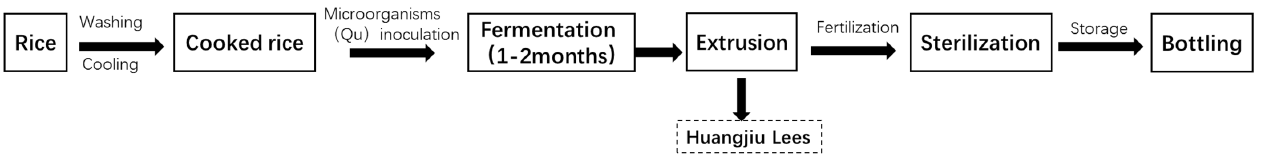
Figure 1. Flow chart for Chinese Huangjiu brewing [9]. Table 1. Component concentration in Huangjiu lees.